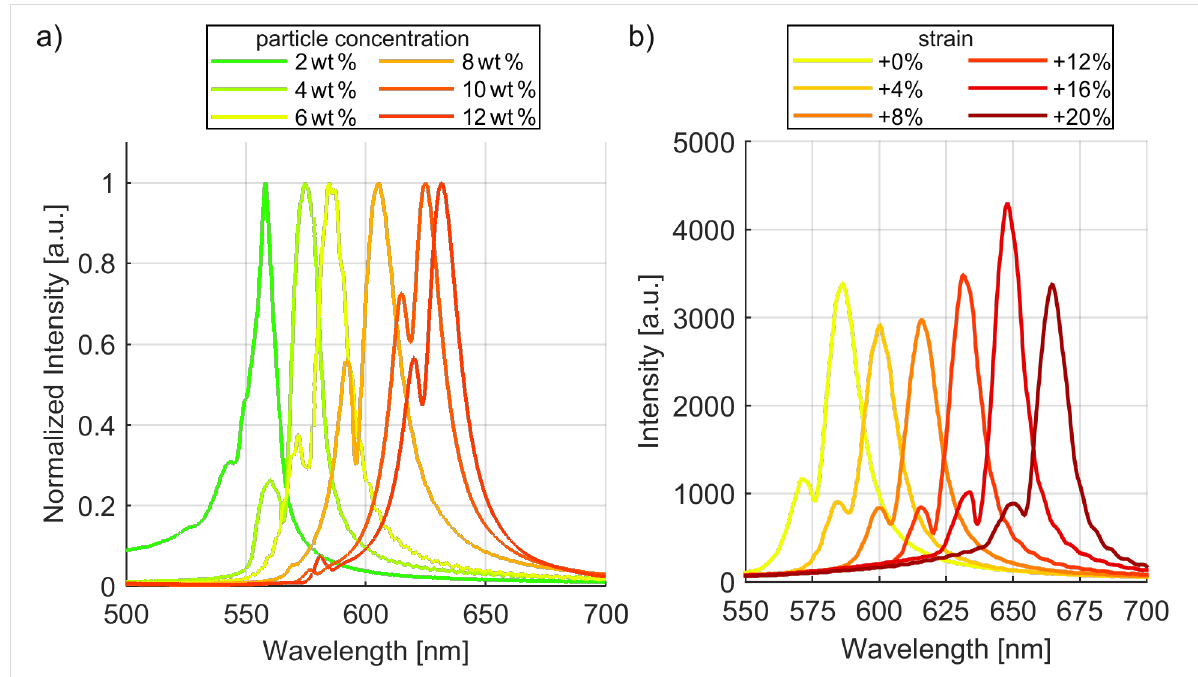
Figure 2: Resonance spectra with crossed polarization filters at a) 0% strain for samples with 2 wt % to 12 wt % TiO 2 and at b) 6 wt % TiO 2 sample for strain values of +0 to +20% perpendicular to the grating direction. A resonance shift from 586 to 664 nm is obtained corresponding to 3.9 nm/% strain.